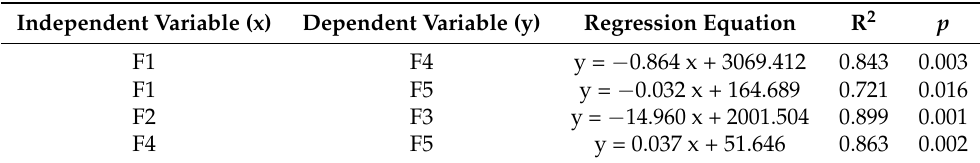
Table 5. Linear regression analysis among